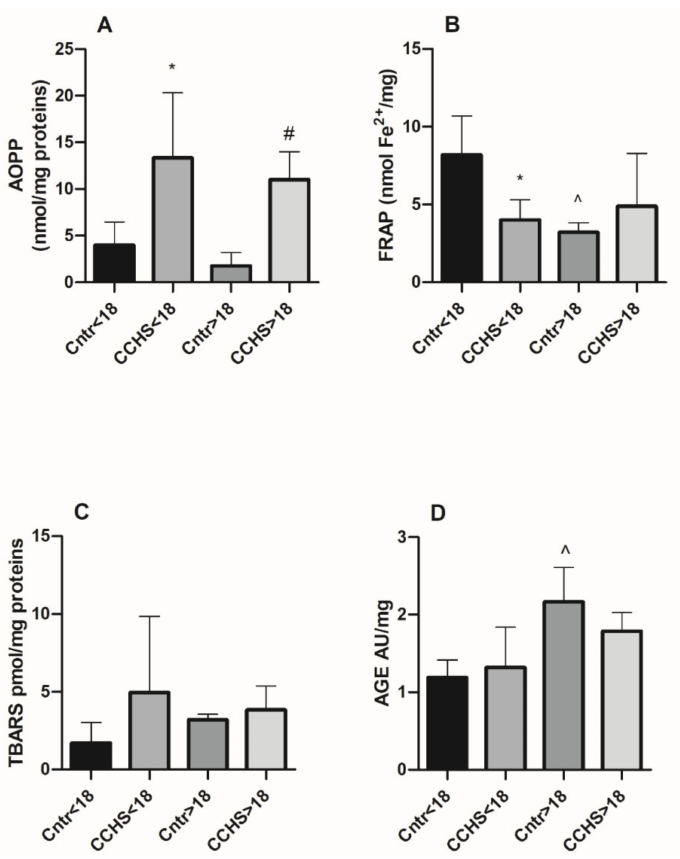
Figure 1. Levels of serum ( A ) AOPP, ( B ) FRAP, ( C ) TBARS, and ( D ) AGEs in healthy controls (Cntr) and CCHS patients aged <18 years and >18 years. Data are expressed as the mean ± SEM. * p < 0.05 vs. healthy minors; # p < 0.05 vs. healthy adults; ˆ p < 0.05 vs. healthy